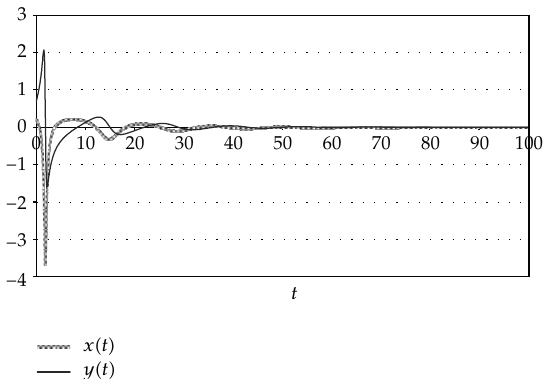
Figure 5: x (cid:2) 0 (cid:3) (cid:6) 0.2, y (cid:2) 0 (cid:3) (cid:6) 0.7, a (cid:6) 0.1, b (cid:6) 0.5, alpha (cid:6) 0.8.